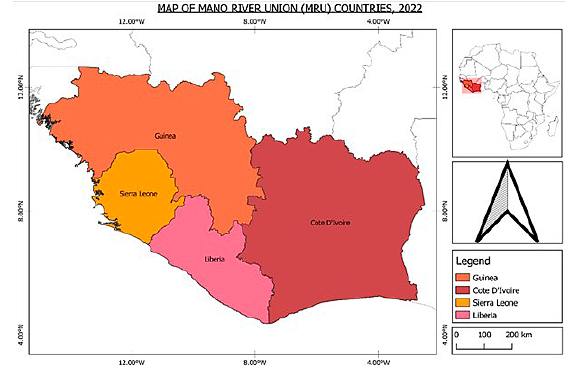
Figure 1. The study area (MRU